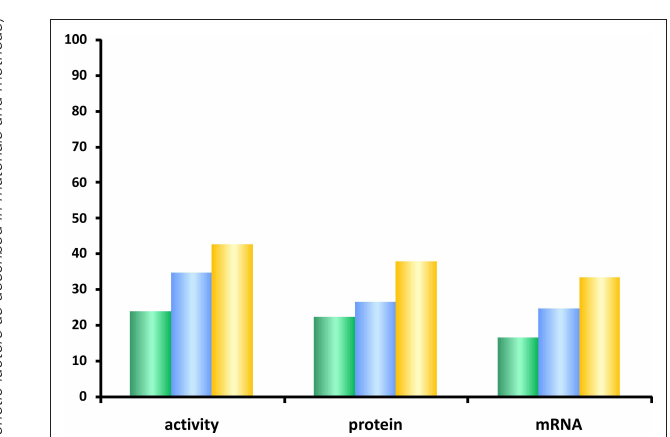
Figure 6 | Contribution of genetic and non-genetic factors to CYP1A2 expression. Percentage of the total CYP1A2 variation as explained by multivariate linear models containing only non-genetic factors (green), only genetic factors (blue), or both combined (yellow). The bars indicate the coefficient of determination adjusted for the number of factors in the different models. As described in the text, the linear models were obtained by a step-wise model selection procedure using Akaike’s information criterion